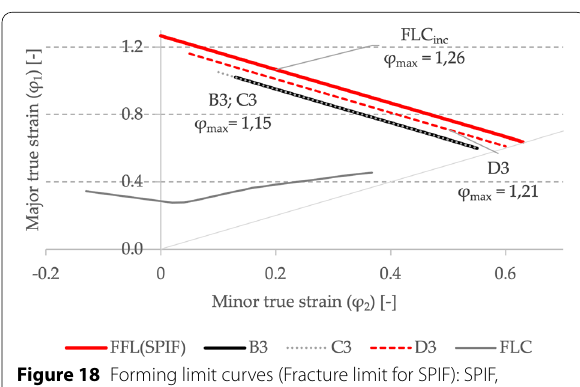
Figure 18 Forming limit curves (Fracture limit for SPIF): SPIF, conventional and